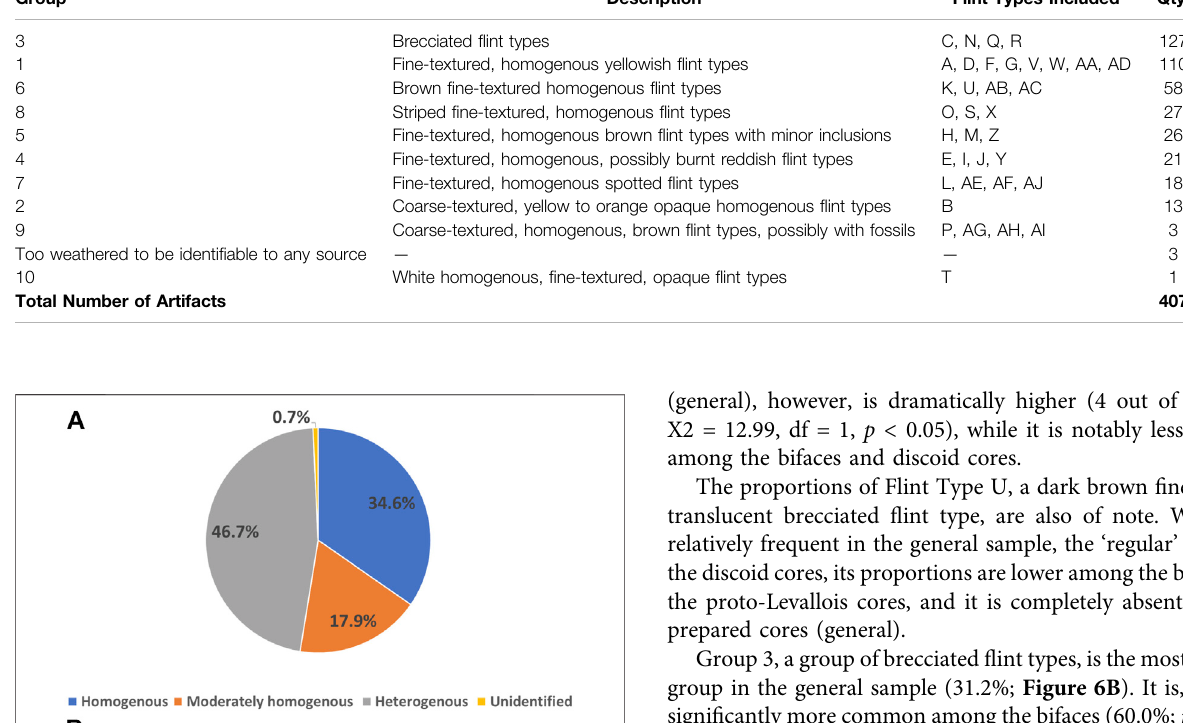
TABLE 3 | List of the Jaljulia groups of fl int types, the fl int types included, their descriptions, and their frequency in the sample. Group